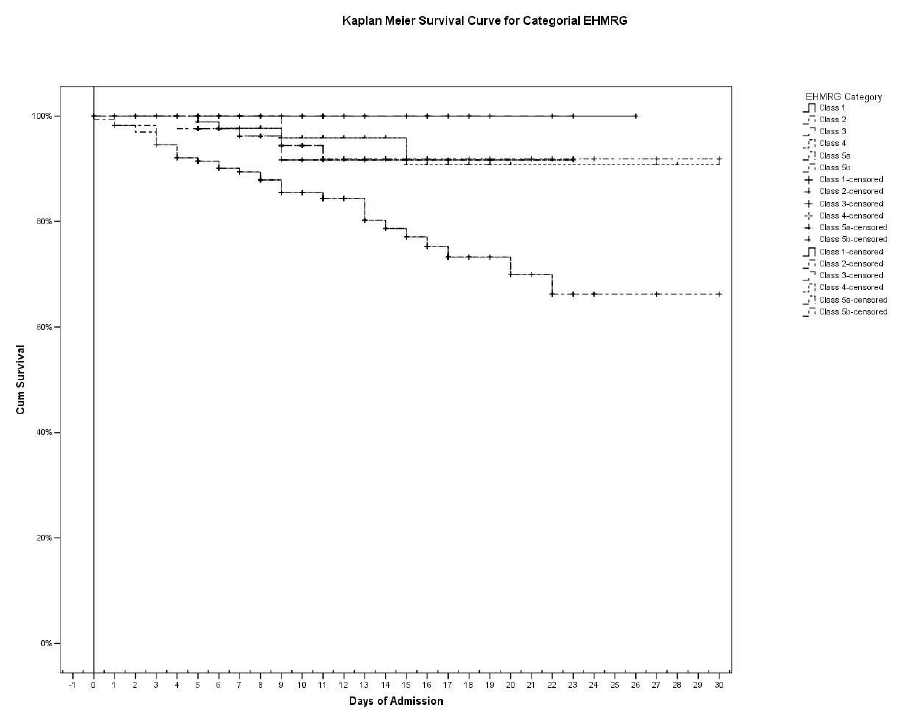
Figure 3. Kaplan–Meier curve of EHMRG, considered as a categorial variable ( p = 0.0001, Figure 3. Kaplan – Meier curve of EHMRG, considered as a categorial variable ( p = 0.0001, log-rank test). log-rank test).